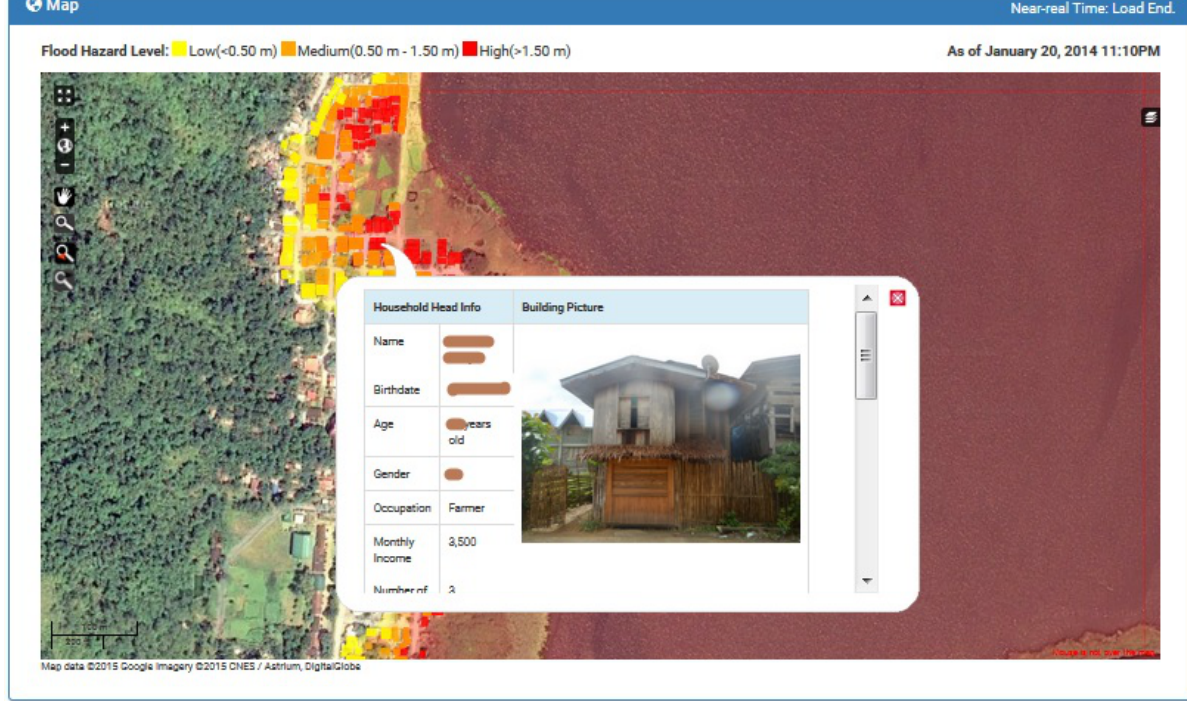
Figure 7: Viewing household-level information of an affected structure such as this is another feature of Flood EViDENs. turnover-of-preliminary-flood-maps-by-dost-secretary-montejo- to-jabonga-local-government-unit/ (01 February